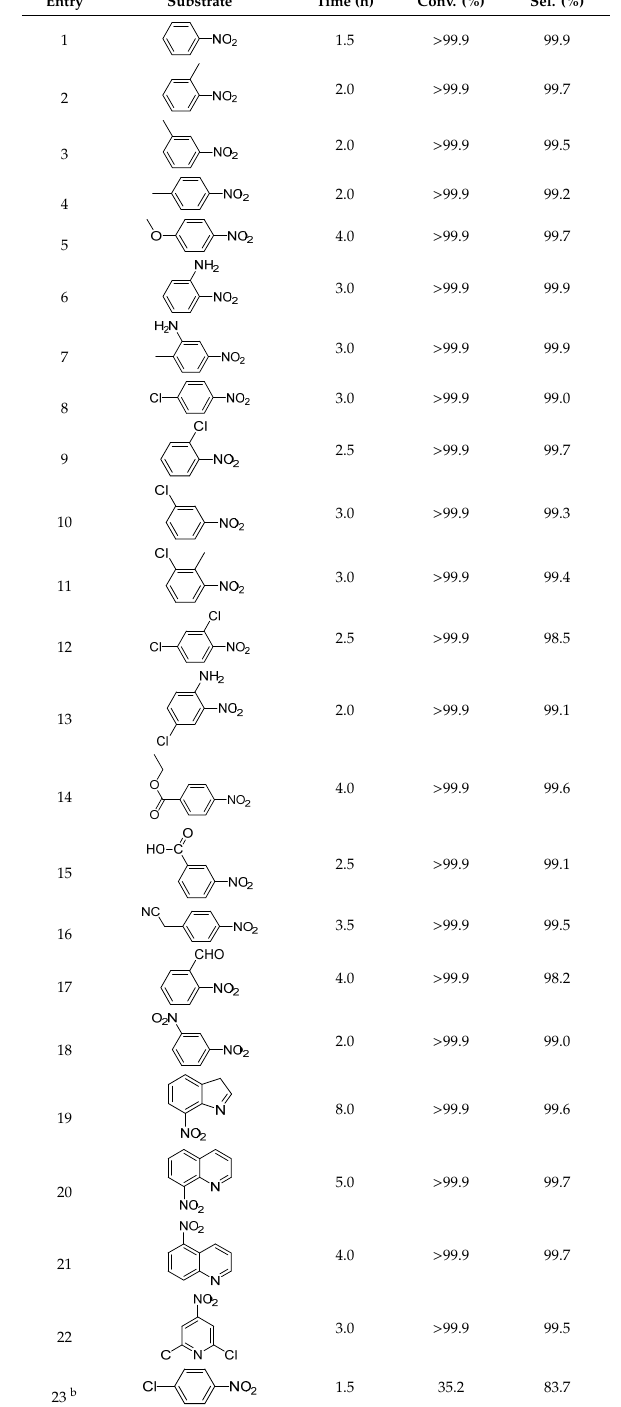
Table 5. Chemoselective hydrogenation of various substituted nitroarenes catalyzed by Pt / N-CMK-3-2 catalyst a . Entry Substrate Time (h)